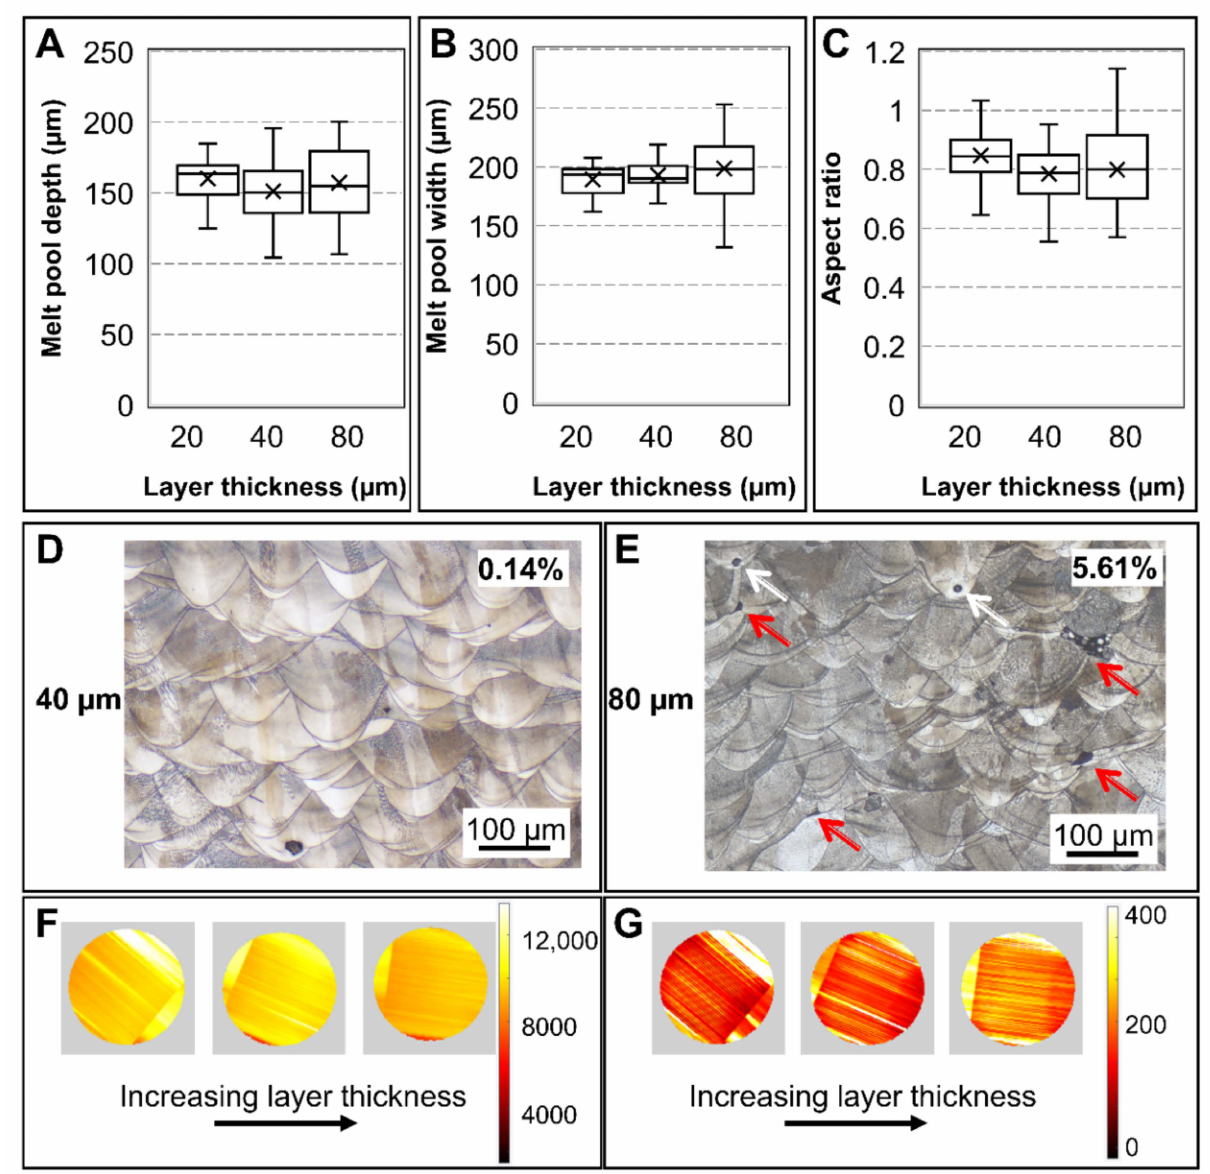
Figure 6. Variation on melt pool geometry, melt pool signal characteristics, and incidence of flaws with a layer thickness in the keyhole regime at 100 W and 200 mm/s. Distributions of melt pool depths ( A ), widths ( B ), and aspect ratios ( C ) with varying layer thickness. In the specimens manufactured with layer thickness 20 µ m and 40 µ m ( D ), only gas and keyhole pores are observed. For layer thickness of 80 µ m, both pores (indicated by the white arrows) and lack of fusion (indicated by the red arrows) are observed ( E ). The volume fraction of flaws is indicated in ( D , E ). ( F , G ) are spatial representations of the intensity and dynamic signal characteristics,